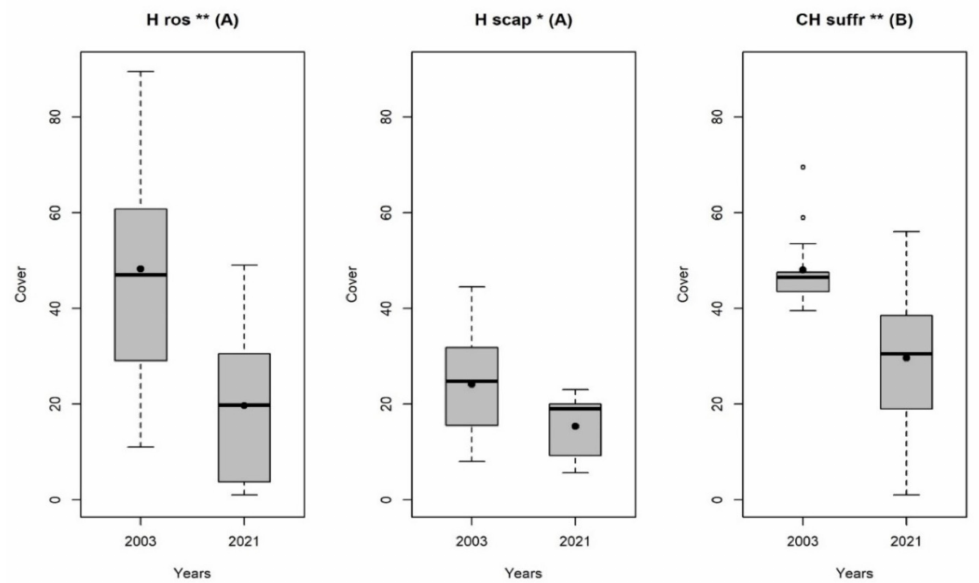
Figure 5. Boxplot comparing cover of growth forms ( sensu Pignatti et al. [74]) in two time steps (T1: 2003 and T2: 2021 in Apennine stripped grasslands (A) and wind edge swards (B). H ros: hemicryp- tophytes with rosette; H scap: scapose hemicryptophytes; CH suffr: suffruticose chamaephytes. Asterisks indicate significant differences according to the Kruskal–Wallis test for equal medians (* p < 0.05, ** p <